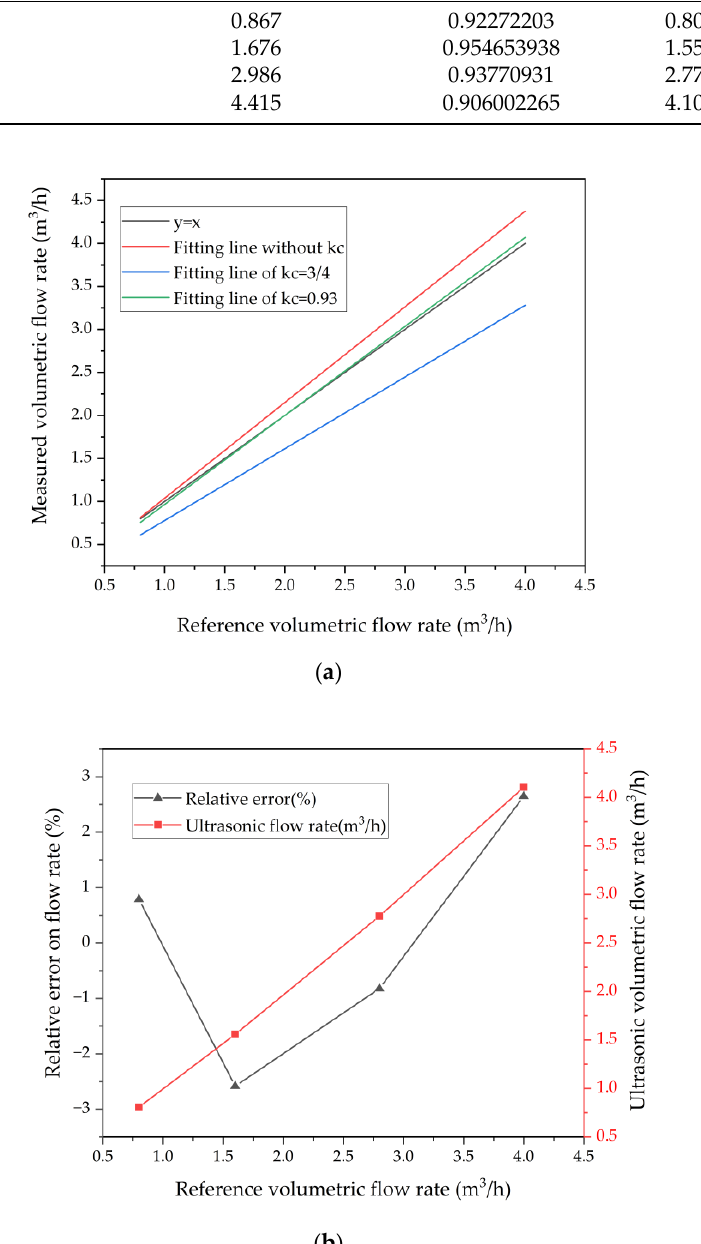
Figure 13. ( a ) The measured volumetric flow rates and the linear fitting results. ( b ) Relative errors on the correctional ultrasonic volumetric flow versus the reference flow rates.